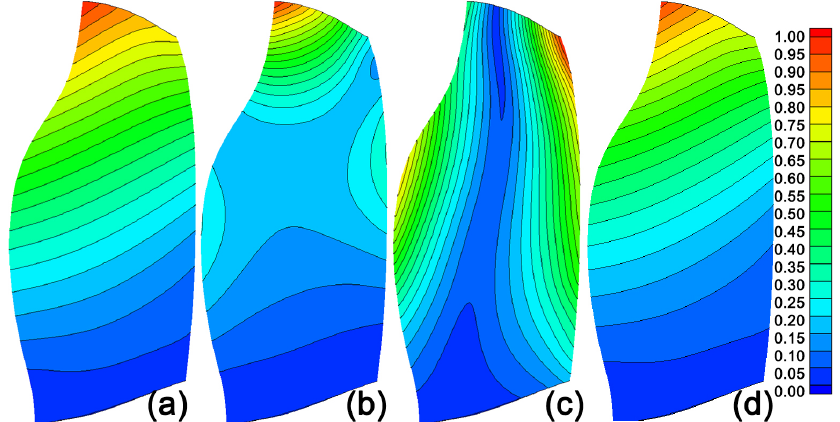
Figure 2. Normalised deflection contour plots for blade from fan 1. ( a ) First flapwise bending modes. ( b ) Second flapwise bending mode. ( c ) First torsional mode. ( d ) Untwist deflection contour at peak efficiency